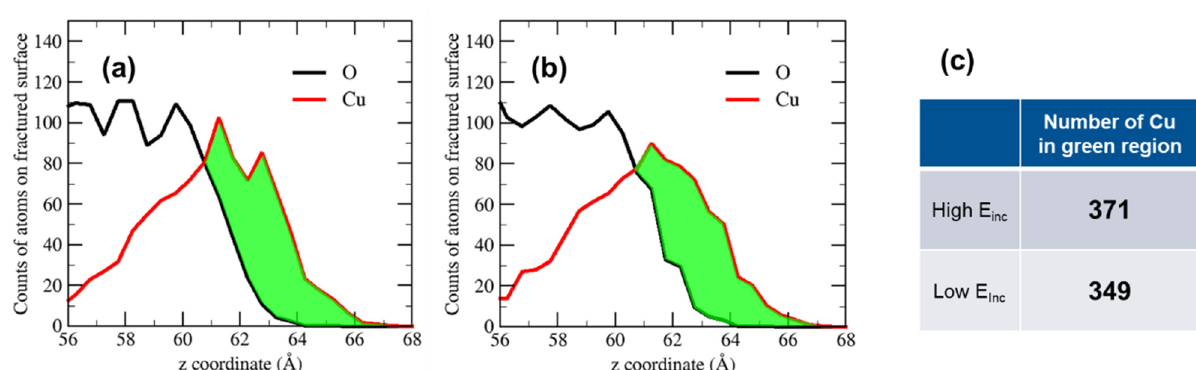
Figure 9. Count of O and Cu atoms along z coordinate around the fractured CAS surface for ( a ) high E inc case and ( b ) low E inc case. Shaded regions represent the number of Cu atoms that are expected to form metallic bonds with Cu film, thus contributing to adhesion strength. ( c ) Comparison of a number of Cu atoms in the green regions for high and low E inc cases.